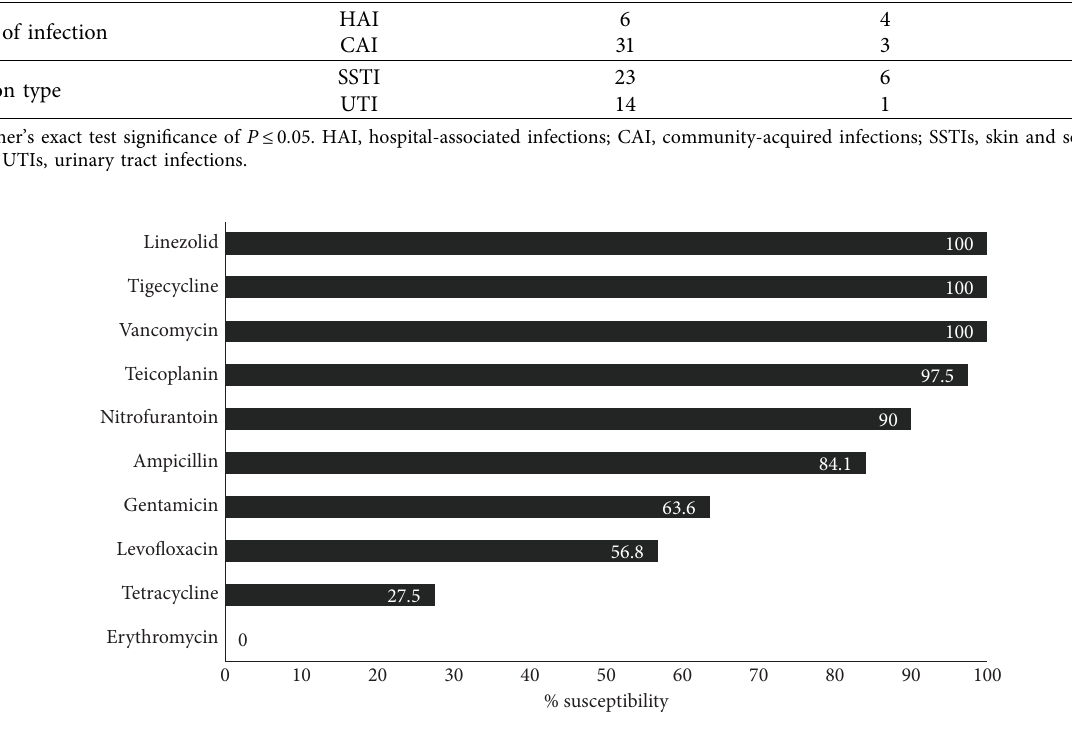
Figure 1: Antimicrobial susceptibility profle of Enterococcus spp. isolates ( n � 44).